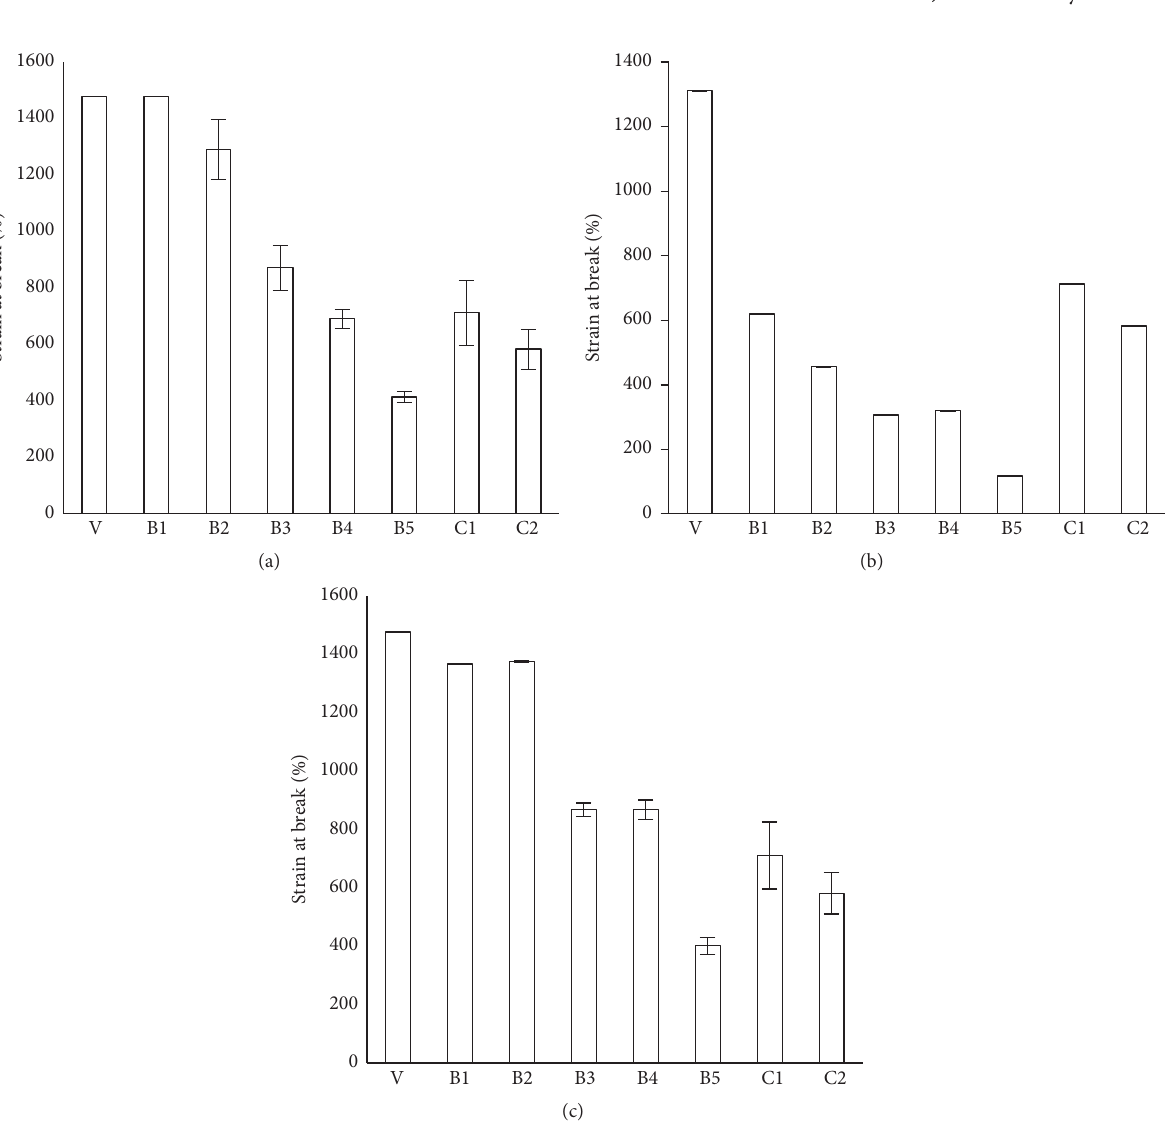
Figure 3: Strain at break (%) measured for the studied materials in comparison to the commercial grade products. Die Head Temperature (DHT) = (a) 175 ∘ C, (b) 185 ∘ C, and (c) 195 ∘